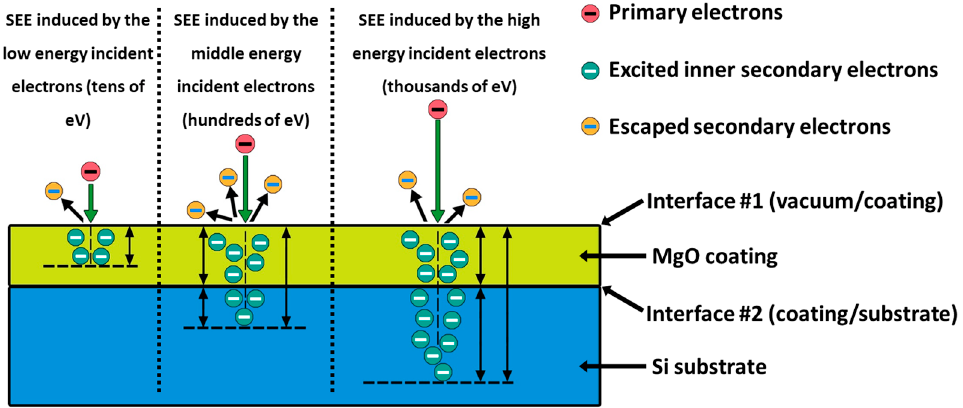
Figure 7. Sketch map of SEE physical processes for an ideal double-layer structure.